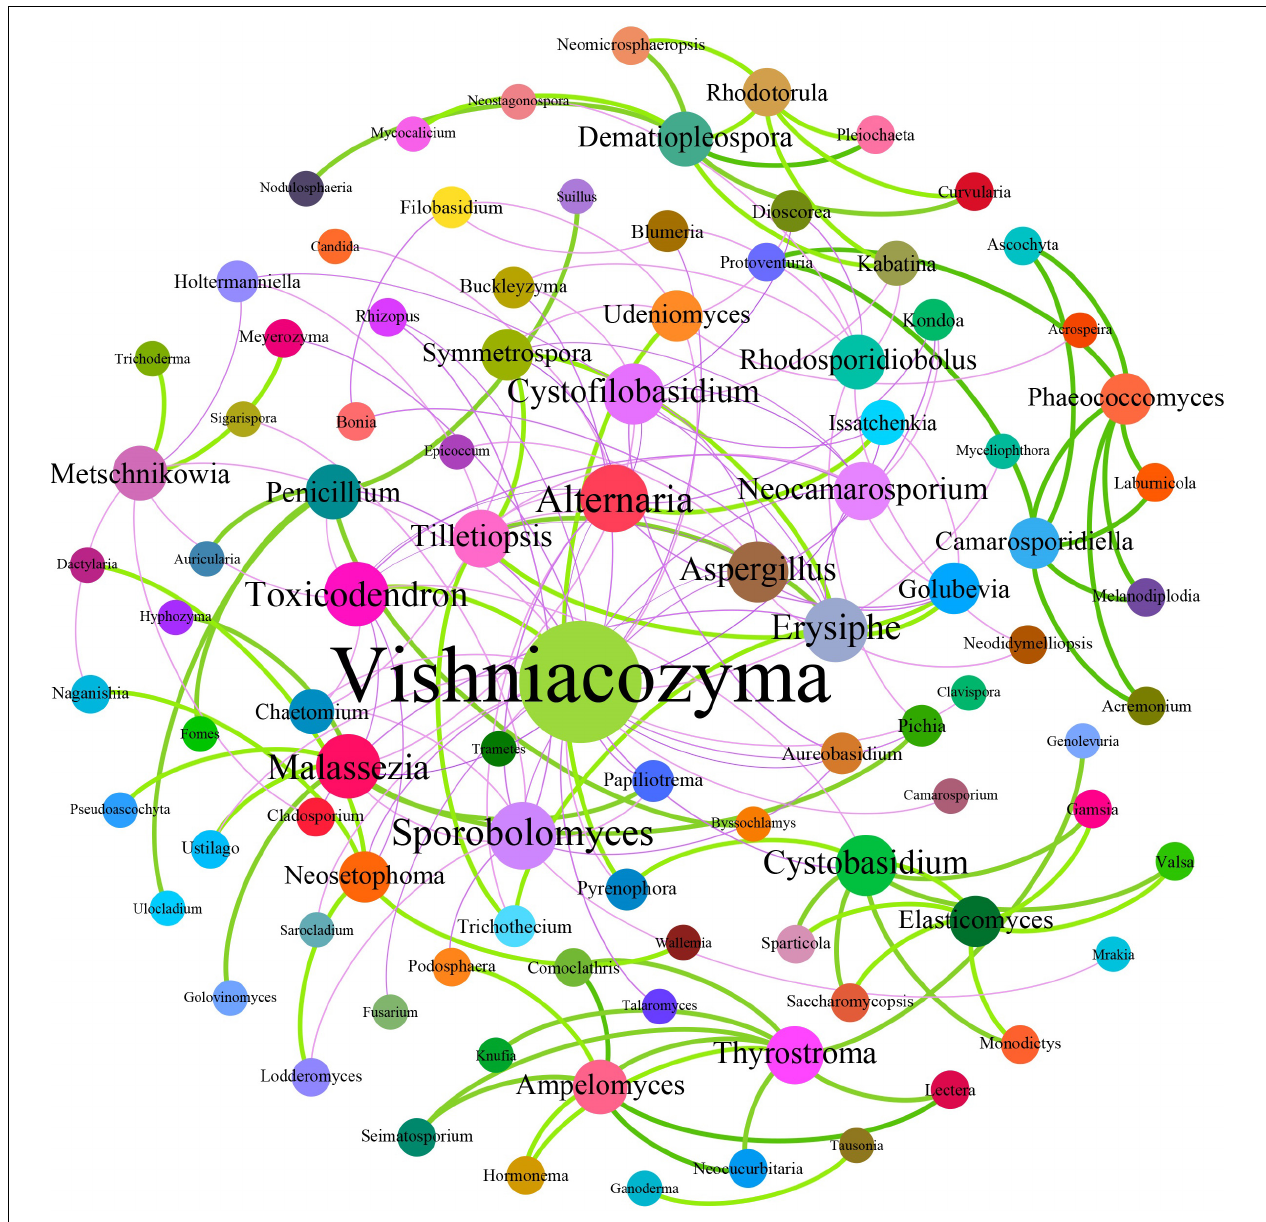
FIGURE 9 | Co-occurrence network among fungi at the genus level. Each dot in the figure represents a species, and the size of the dot indicates the number of related relationships with other species. Solid lines indicate positive correlations; dash lines indicate negative